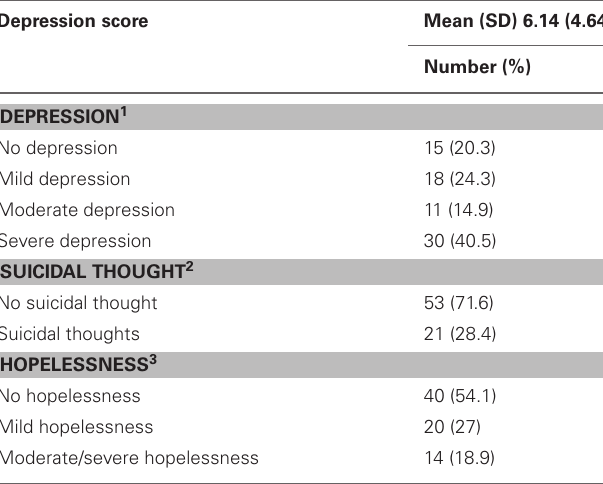
Table 2 | Depression, suicidal thinking, and hopelessness (Calgary depression scale).